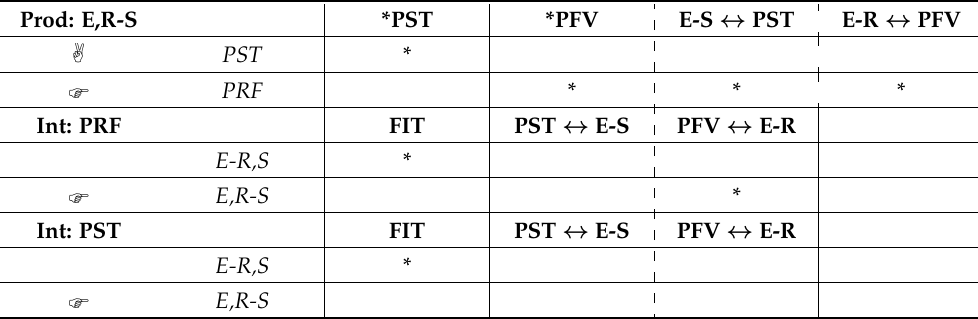
Tableau 4. Asymmetrical optimization in French, German, and Dutch (example (11)). Tableau 1. Bidirectional optimization of tenses. Tableau 2. Asymmetrical optimization in English and Spanish (example (12)).